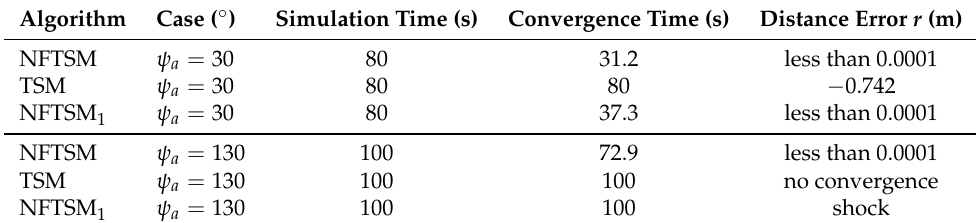
Table 3. The convergence time of stationary target